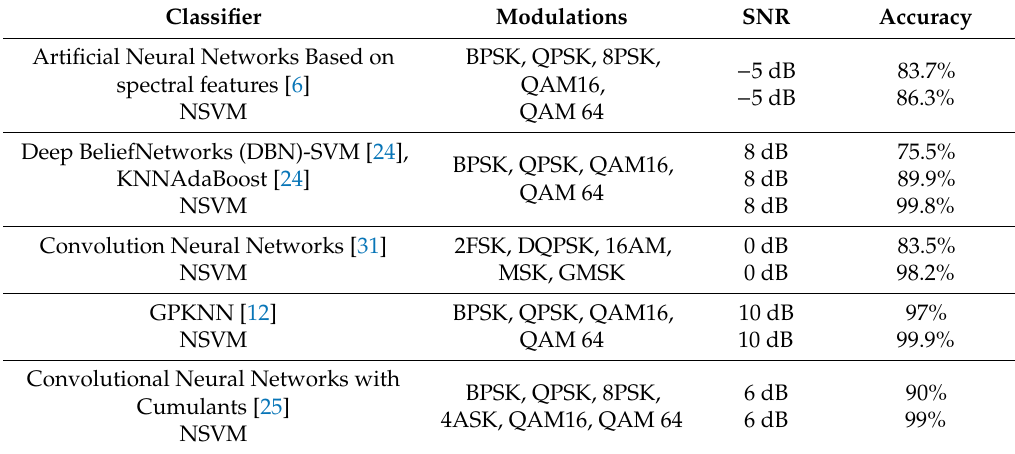
Table 4. Comparison with other